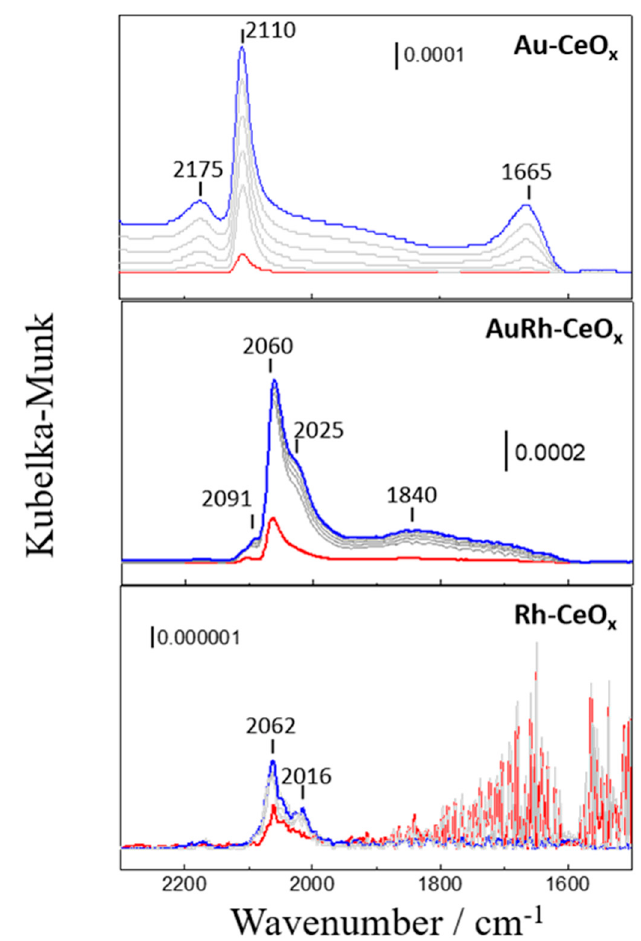
Figure 11. In situ DRIFTS spectra recorded during CO adsorption on the Au–CeO x /Al 2 O 3 , AuRh– CeO x /Al 2 O 3 , and Rh–CeO x /Al 2 O 3 at 30 °C for 5 min (from the red line to the blue line at an interval of 1 min). Gas mixture: 2000 ppm CO and He balance; total flow rate: 100